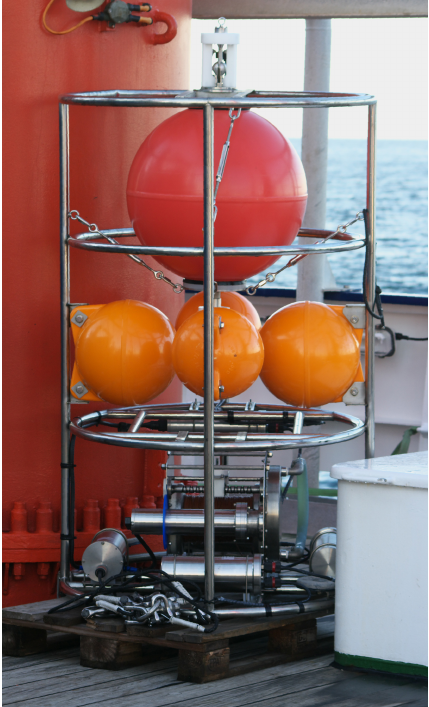
Figure 3. Underwater winch on deck after recovery from the second deployment in August